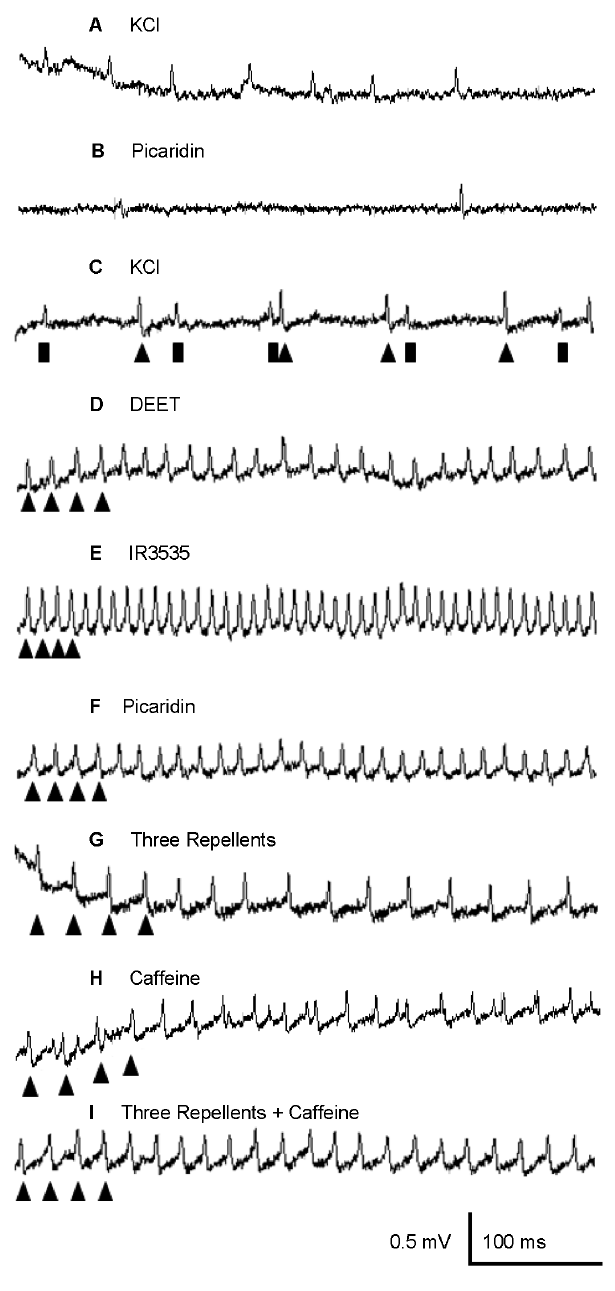
Figure 2. Representative traces of responses elicited from gustatory receptor neurons contained in the medial and lateral styloconic sensilla of Lymantriadispar larvae to various stimuli. (A) 30 mM KCl (lateral), (B) 10 mM Picaridin (lateral), (C) 30 mM KCl (medial), (D) 10 mM DEET (Medial), (E) 10 mM IR3535 (Medial), (F) 10 mM Picaridin (Medial) (G) a mixture of 10 mM DEET, IR3535, and picaridin, (H) 10 mM caffeine, and (I) a mixture of 10 mM caffeine and 10 mM each of DEET, IR3535, and picaridin. Stimulations of lateral styloconic sensilla with the three repellents, picaridin (shown above in B), IR3535, or DEET did not elicit responses from the gustatory receptor neurons. Up-arrowheads represent the response of the large-amplitude deterrent-sensitive neuron and bars represent the response of the small-amplitude KCl-sensitive neuron.